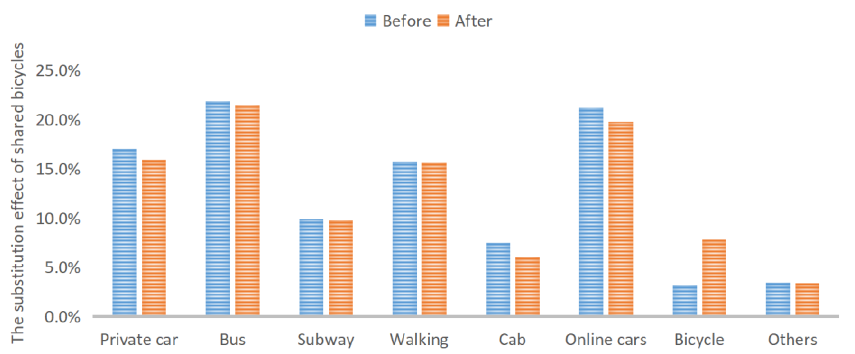
Figure 6. The substitution effect of bicycle-sharing.